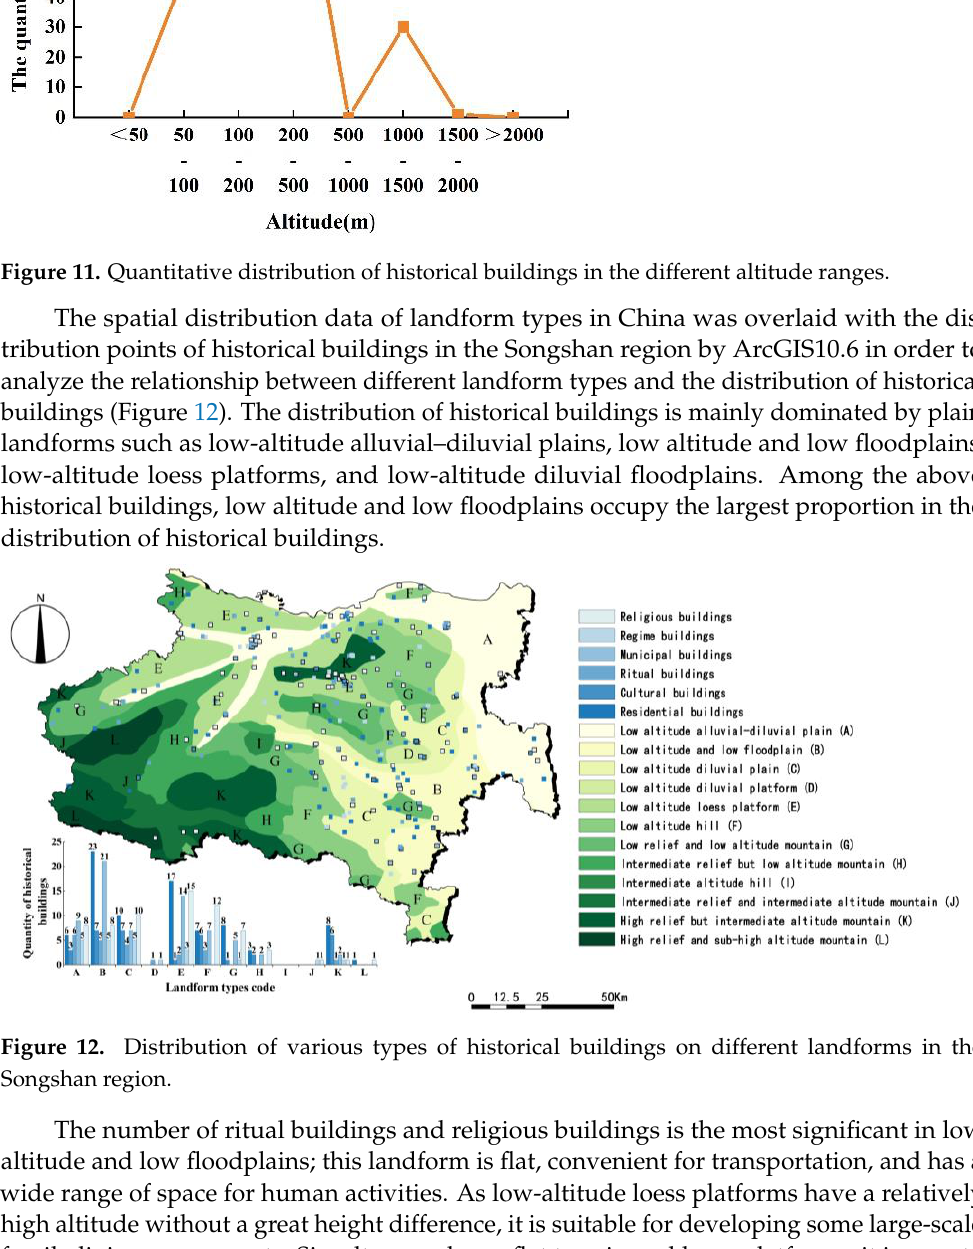
Figure 10. Spatial distribution of historical buildings in different altitude ranges.